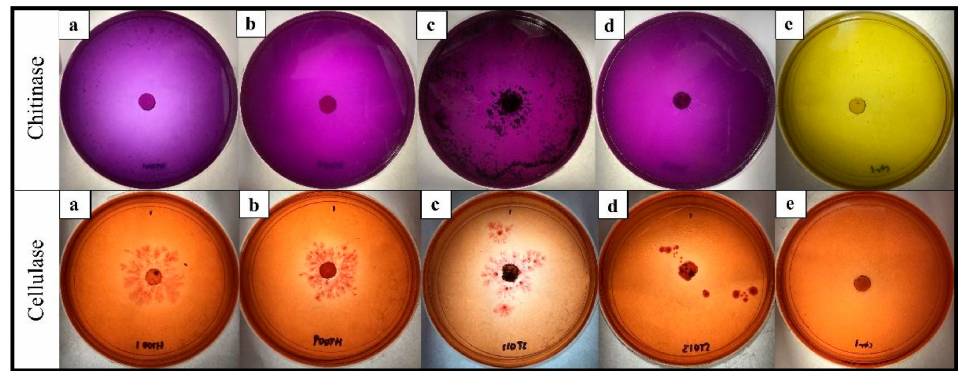
Figure 3. Colorimetric detection of chitinase and cellulase produced by Trichoderma isolates. ( a ) T. koningiopsis HT001, ( b ) T. spirale HT009, ( c ) T. asperellum ST011, ( d ) T. reesei ST013, and ( e ) the control plate on the colloidal chitin (top row) and the carboxymethyl cellulose (bottom row) agar medium. The purple-colored zone on the colloidal chitin agar plate around the colony indicates chitinase production. The formation of a yellow and opaque zone around the colony growing on the carboxymethyl cellulose agar indicates cellulase